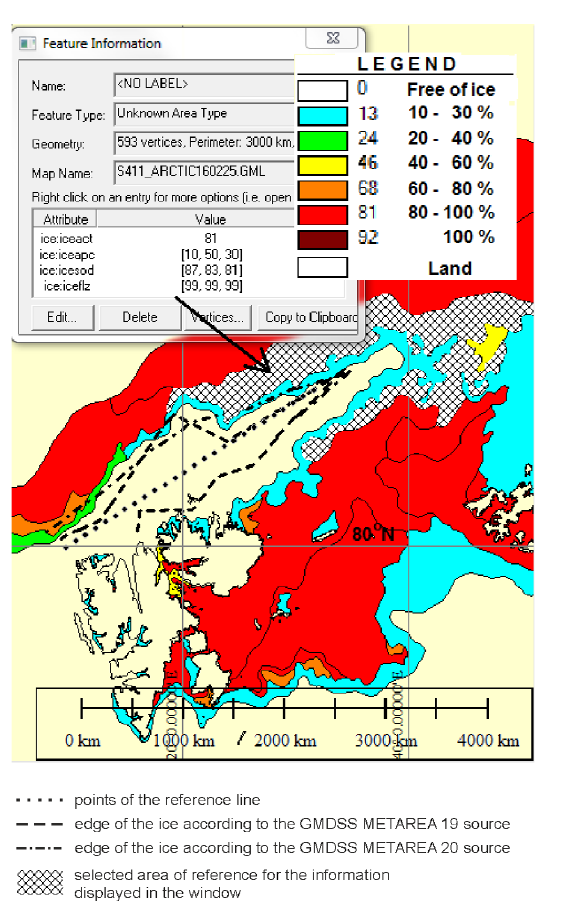
Fig. 6. Map of sea ice in the GML format of S-411